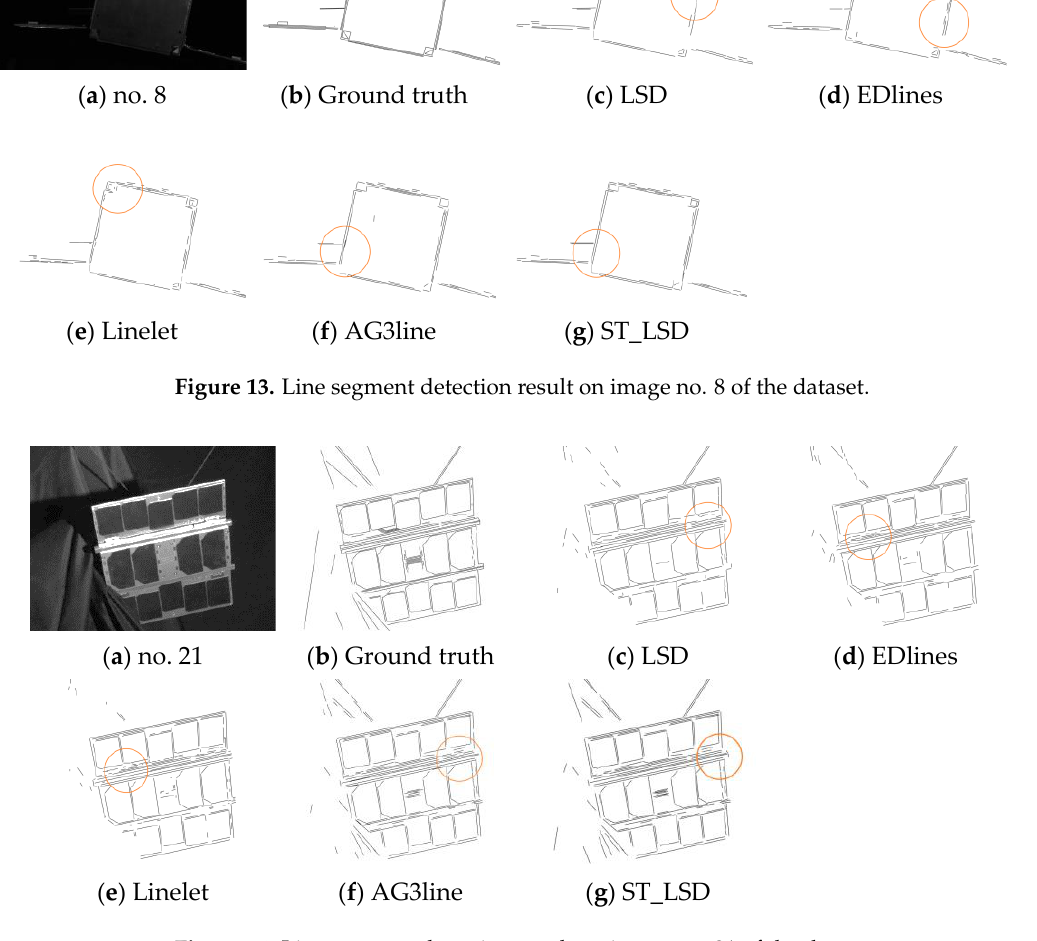
Figure 14. Line segment detection result on image no. 21 of the dataset.